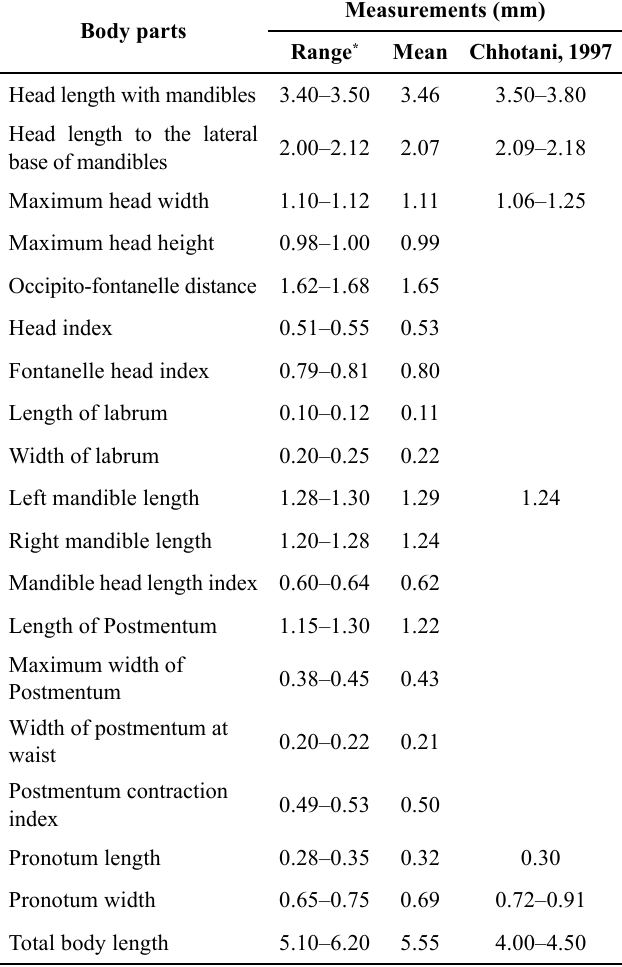
Table 1 . Measurements of soldiers of Pericapritermes ceylonicus (Holmgren,